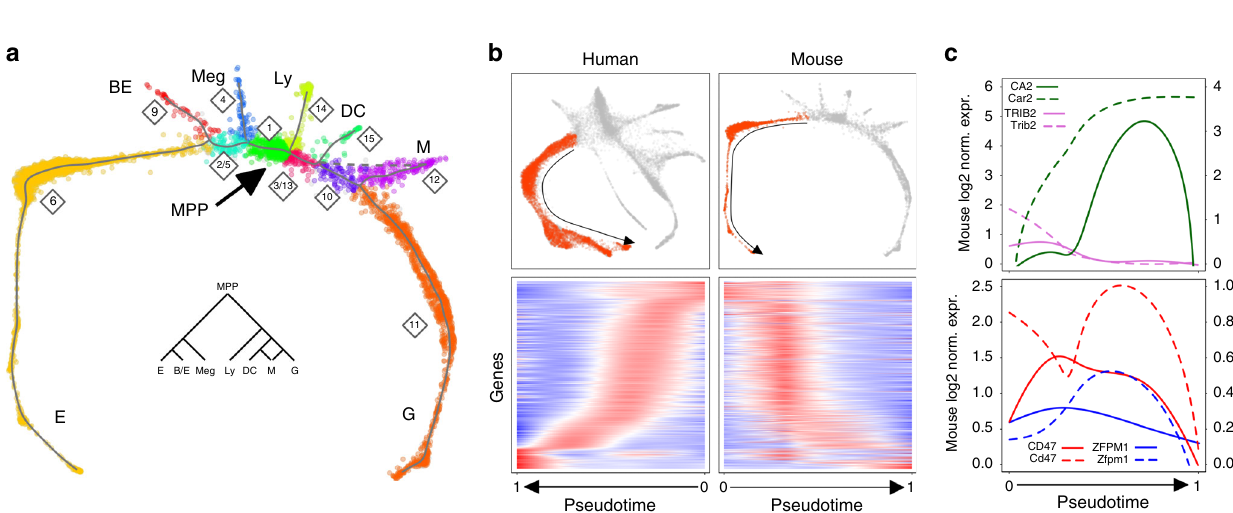
Fig. 4 Human Lin − CD34/CD164 versus mouse Kit + transcriptome map and gene expression dynamics analysis. a Classi fi cation of individual cells into 11 homogenous transcriptional groups, based on inferred principal trajectories on mouse Kit + transcriptome data (Supplementary Fig. 3c for details). Group labels and colors have been set to highlight similarities with Lin − CD34/CD164 fractionating map. Solid lines show results based on fi nal converged iteration (Supplementary Fig. 3c for details). Dashed lines added manually to highlight a potential additional trajectory not present in fi nal iteration and suggested by PBA analysis reported in the middle (DC-M). MPP, MultiPotent progenitor cells; Meg, megakaryocytes; BE, baso/eosinophils; E, erythroid cells; Ly, lymphoid cells; DC, dendritic cells; M, monocytes; G, granulocytes. b Comparison of human and mouse transcriptional states during erythropoiesis. Upper panels, schemes of the comparison. Mirror heatmaps, expression of the 721 orthologous genes selectively expressed along the human and mouse erythroid differentiation (LRT adjusted p value < 0.05). c Representative comparable dynamics of the orthologues TRIB2/Trib2 and CA2/Car2 reported in Tusi et al. 24 vs divergent dynamics of the orthologues CD47/Cd47 and ZFPM1/Zfpm1 reported in Pishesha et al.